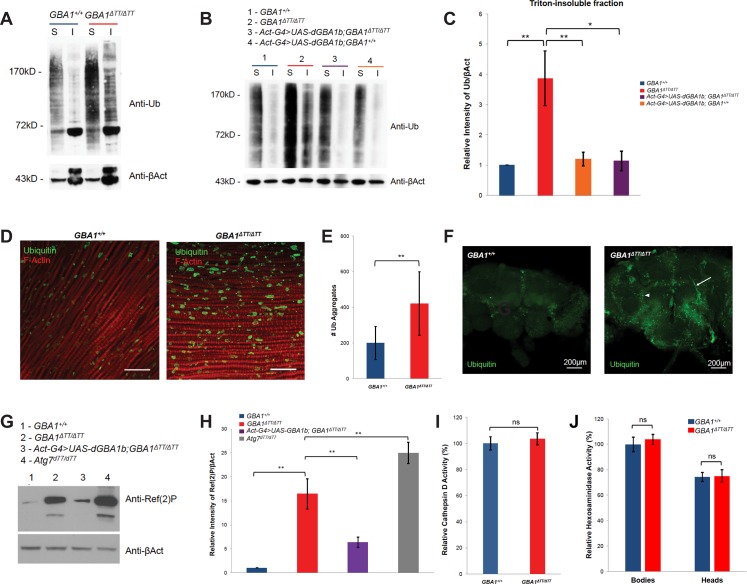
GBA1ΔTT/ΔTT exhibit increased accumulation of soluble and insoluble ubiquitinated proteins.(A) Western blot using antiserum to ubiquitin (Ub) of Triton-soluble (S) and Triton–insoluble (I) protein fractions from whole 30-day-old WT controls (GBA1+/+) and GBA1ΔTT homozygotes (GBA1ΔTT/ΔTT), using anti-β-Actin (βAct) as a loading control. The intense ubiquitin-positive band immediately below the 72kD marker and the upper βAct band likely represents arthirin, a 55kD mono-ubiquitinated form of β-Actin that is present exclusively in the indirect flight muscle [68]. (B) Western blot probed for Ub of Triton–soluble (S) and Triton–insoluble (I) protein fractions from heads of flies of 30-day-old GBA1+/+, GBA1ΔTT/ΔTT, WT controls ectopically expressing Drosophila WT dGBA1b using the Actin GAL4 driver (Actin-GAL4>UAS-GBA1b;GBA+/+), and GBA1ΔTT homozygotes ectopically expressing Drosophila WT dGBA1b using the Actin GAL4 driver (Act-GAL4>UAS-GBAb;GBA1ΔTT/ΔTT), using βAct as a loading control. (C) Densitometric quantification of Ub signal in the Triton-insoluble fraction from the heads of flies of the indicated genotypes. Levels of Ub signal per genotype were normalized to respective βAct loading controls, and these ratios were in turn normalized to the insoluble Ub level of GBA1+/+. (D) Representative immunofluorescent staining of thoracic muscle from 30-day-old GBA1+/+ and GBA1ΔTT/ΔTT flies with anti-Ub and anti-F-Actin. Scale bars, 20 μm. (E) Quantification of Ub-positive objects within 10-μm-thick Z-stacks of thoracic muscle of 30-day-old GBA1+/+ and GBA1ΔTT/ΔTT flies. At least 9 separate Z-stacks were analyzed per genotype. Error bars represent standard deviation. (F) Representative anti-Ub immunofluorescent staining of 30-day-old whole brains from GBA1+/+ and GBA1ΔTT/ΔTT flies. Scale bar, 200 μm. Arrowhead indicates punctate staining pattern, arrow indicates filamentous staining pattern. (G) Western blot using antiserum to Ref(2)P of whole 10-day-old flies of the indicated genotypes, including Atg7 null flies (Atg7d77/d77). βAct was used as a loading control. (H) Densitometric quantification of Ref(2)P signal from 10-day-old whole flies of the indicated genotypes. Levels of Ref(2)P signal per genotype were normalized to respective βAct loading controls, and these ratios were in turn normalized to the Ref(2)p level of GBA1+/+. (I) Cathepsin D activity in whole 7-day-old GBA1ΔTT homozygotes relative to age-matched controls. (J) Hexosaminidase activity in bodies excluding heads, and isolated heads of 7-day-old GBA1ΔTT homozygotes relative to age-matched controls. Error bars represent s.e.m. unless indicated, ns indicates p>0.05, *p<0.05, **p<0.005 by Student t test in all results shown in this figure.